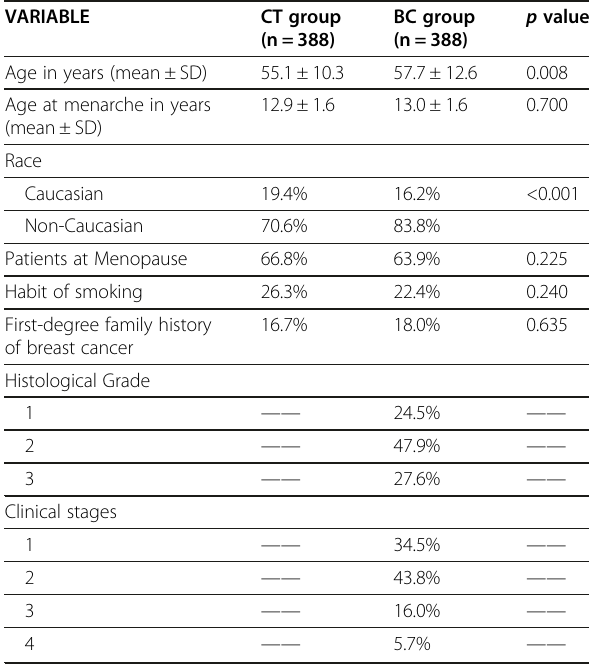
Table 1 Summary of demographic characteristics and risk